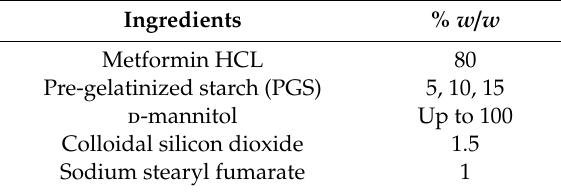
Table 4. The quantitative composition of metformin hydrochloride